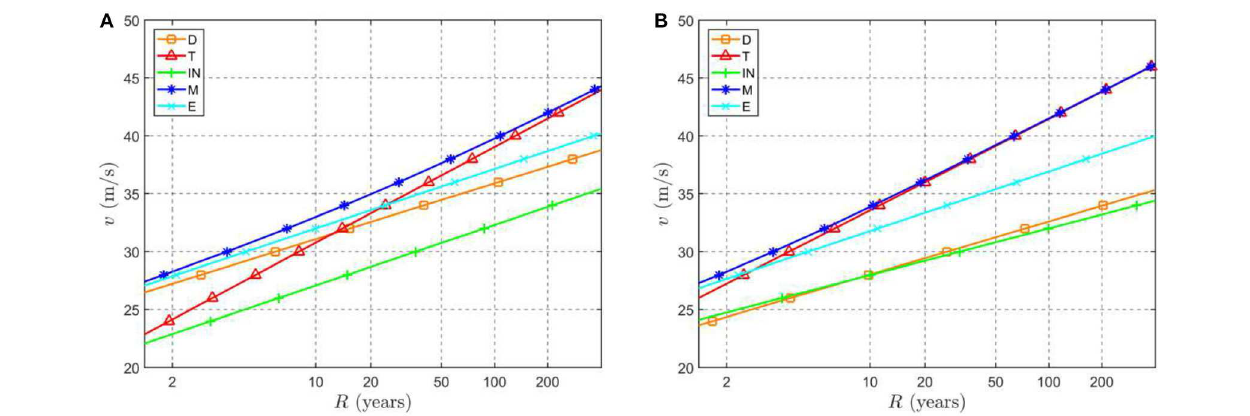
FIGURE 4 | Peak wind velocity as a function of the return period: (A) Port of Livorno; (B) Port of La Spezia (D: Depression; T: Thunderstorms; IN: Intermediate events; M: Mixed distribution; E: Ensemble distribution). Reproduced from Zhang et al. (2018b) with permission from